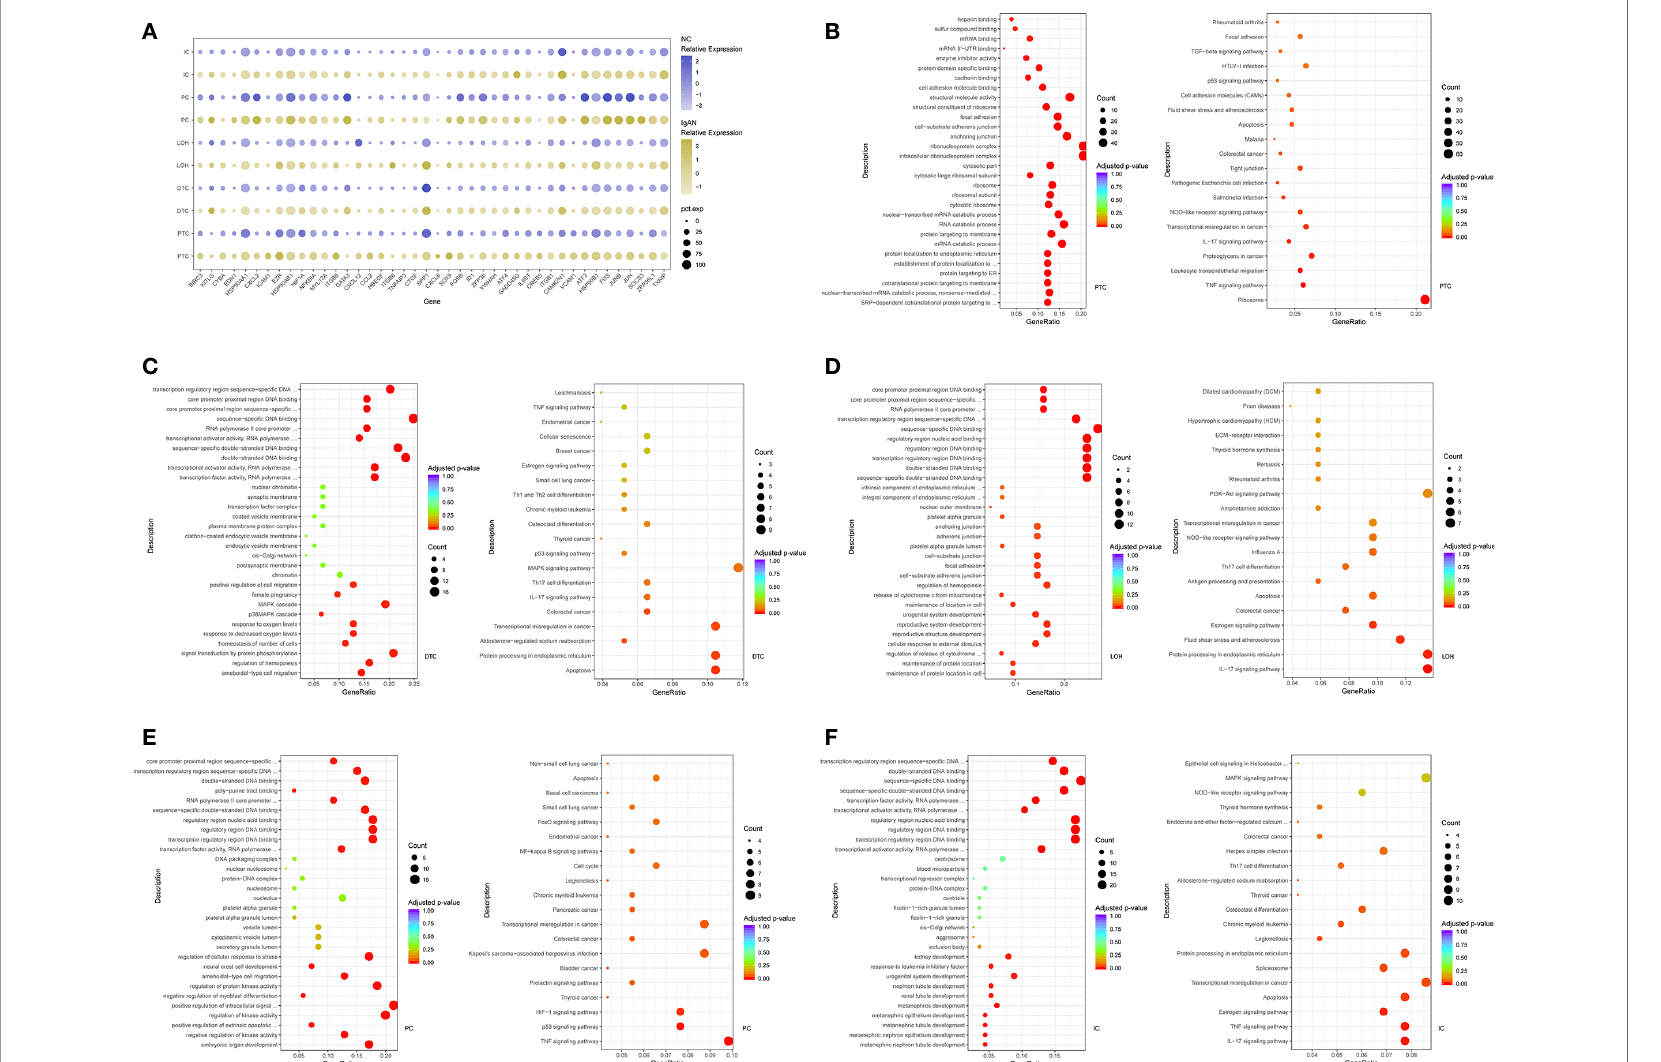
FIGURE 3 | DEGs and intercellular signaling in tubules of IgAN and control subjects. (A) Representative DEGs in proximal tubule cells, distal tubule cells, loop of Henle cells, principal cells, and intercalated cells by comparing the transcriptional pro fi le of IgAN and control subjects. (B) GO enrichment analysis displayed that upregulated DEGs in proximal tubule cells were enriched in some biological processes, KEGG analysis showed these genes in proximal tubule cells were mainly involved in the pathways, such as TNF signaling, IL-17 signaling, and NOD-like receptor signaling pathway. (C – F) GO and KEGG enrichment analysis of DEGs in distal tubule cells, loop of Henle cells, principal cells, and intercalated cells respectively comparing IgAN to control subjects. Abbreviations were as follows: pct.exp, percentage of cells expressing gene; count, number of genes annotated to GO terms or KEGG